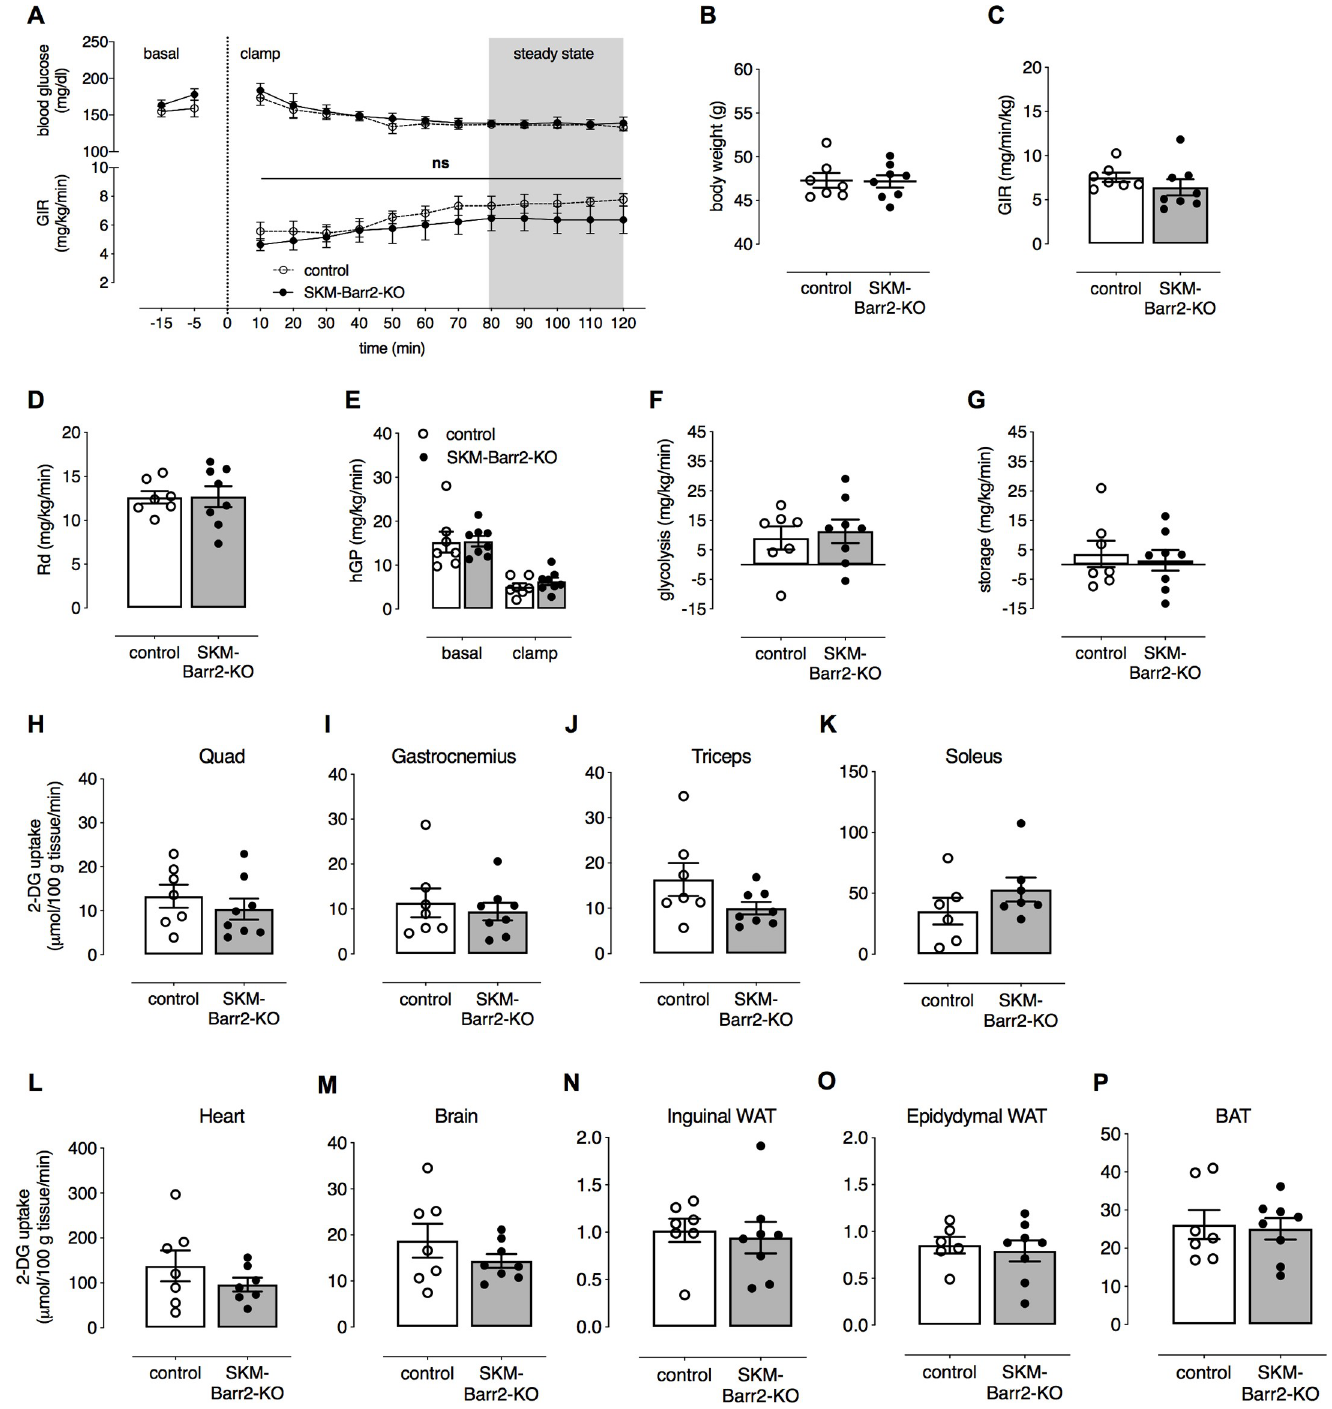
Fig 3. HFD SKM-Barr2-KO mice show no metabolic phenotype in hyperinsulinemic-euglycemic clamp studies. Hyperinsulinemic-euglycemic clamps were performed in conscious, unrestrained HFD control and SKM-Barr2-KO mice (adult males) that had been fasted for 5 h. (A) Time course of blood glucose levels and glucose infusion rates (GIR) during the course of clamps. (B) Body weights. (C) GIR during the steady-state period of the clamp. (D) Whole body glucose clearance (Rd). (E) Hepatic glucose production (hGP) under basal and steady-state conditions. (F) Glycolysis rate. (G) Glycogen storage rate. (H-P) Glucose uptake into SKM tissues (H-K) and other metabolically important tissues (L-P). Quad, quadriceps muscle; WAT, white adipose tissue; BAT, brown adipose tissue. 2-DG tissue uptake was determined as described in Materials and Methods. Data are shown as mean ± SEM (7–8 mice per group). Ns, no statistically significant difference (2-way-